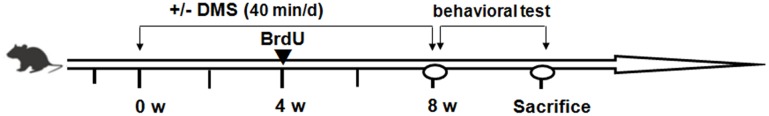
Experimental design and timeline of procedures. Mice in the DMS-treated group were given an 8-week DMS treatment before starting the behavioral tests. During the fourth week before starting behavioral tests, mice received daily BrdU injections (arrowheads).